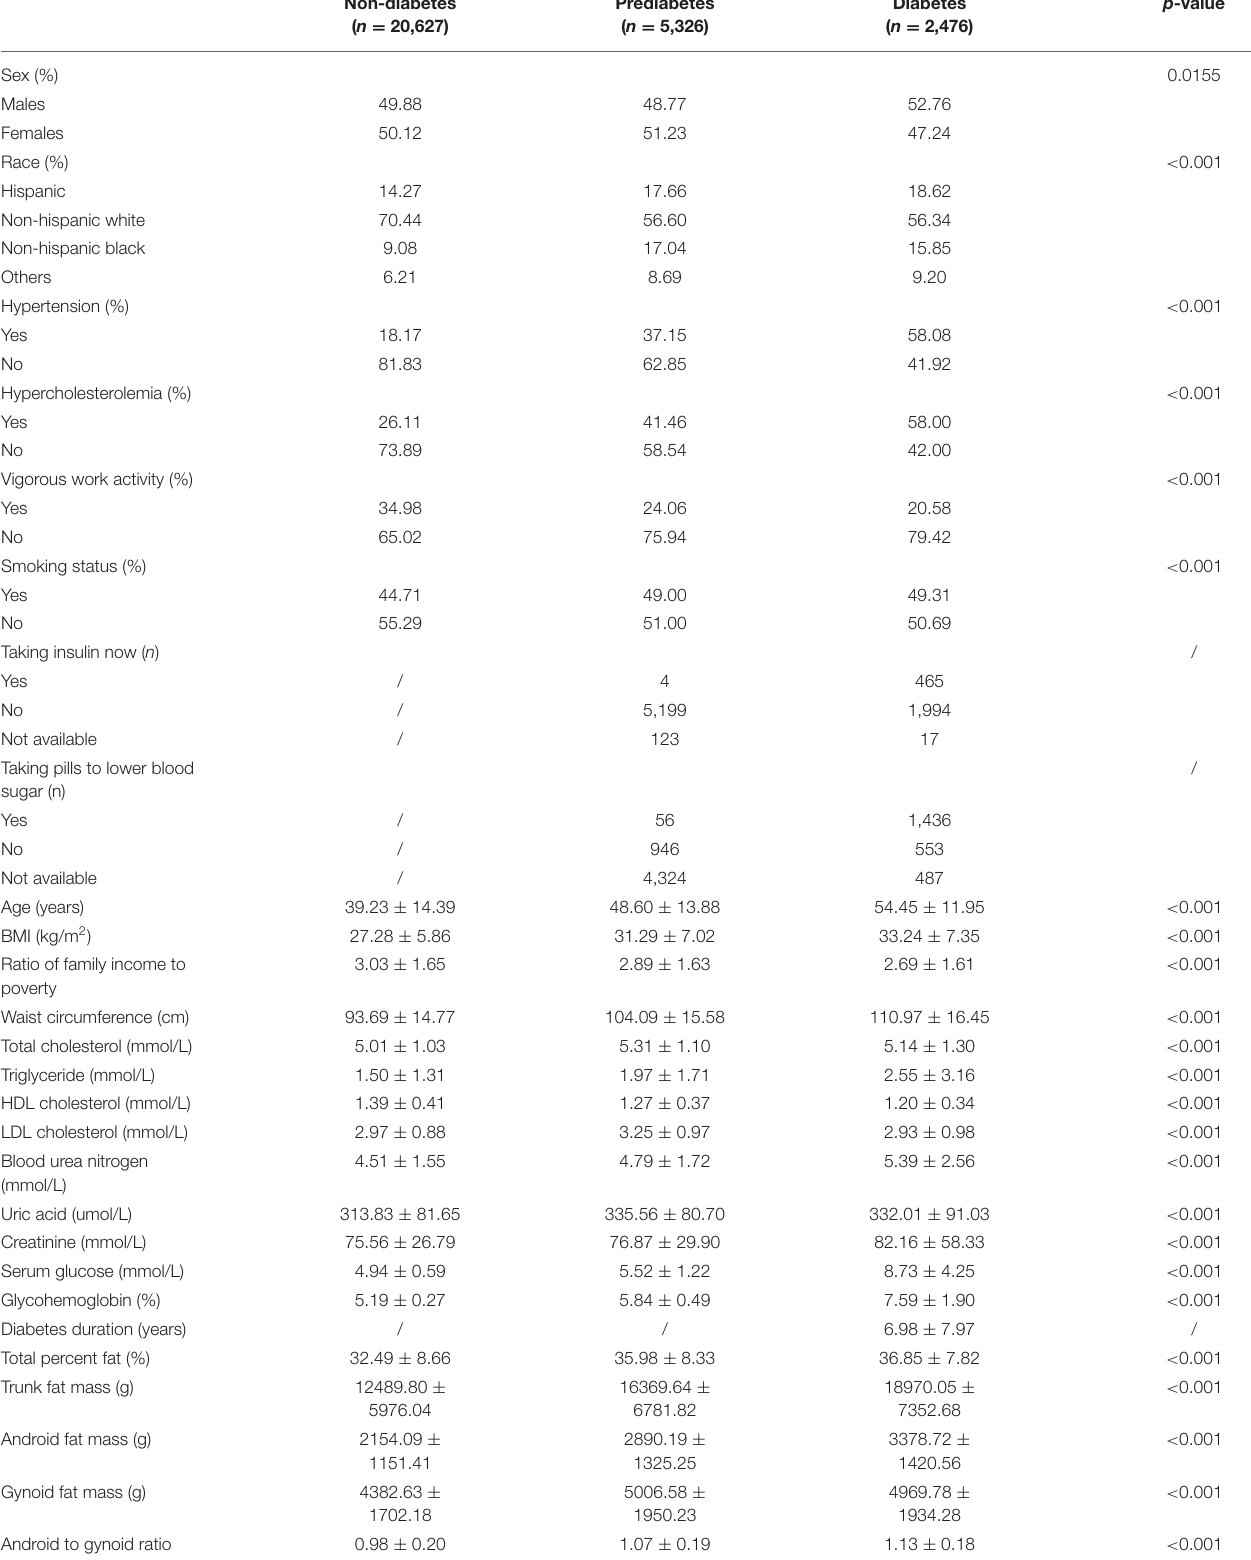
TABLE 1 | Weighted characteristics of study samples based on diabetes status.